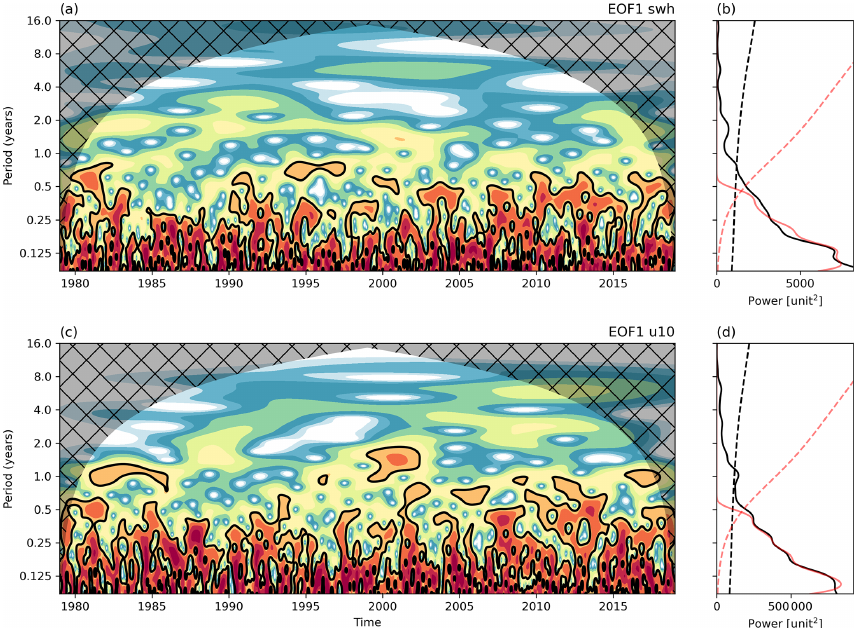
Figure 4. Wavelet power spectrum of the EOF1 of swh anomaly (a) and u 10 anomaly (b) ; the black contours represent the 95% confidence level. Global wavelet spectrum of swh (c) and u 10 (d) for the anomaly fields (black) and filtered anomaly fields (red). Dashed lines represent the 95% confidence level considering a red noise based on a univariate lag-1 autoregressive